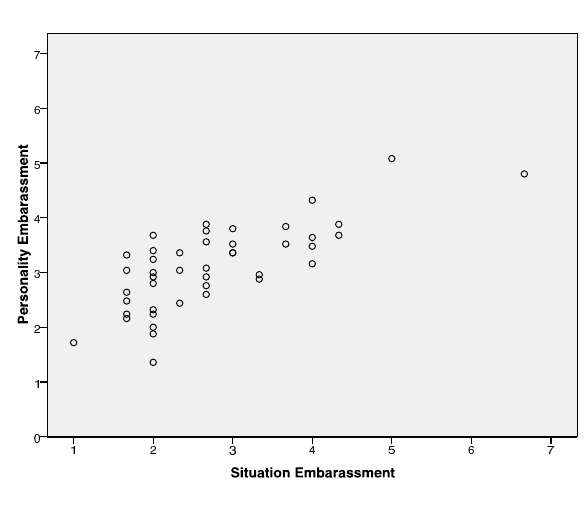
Figure 6. Scatter plot of Situation Embarrassment against Personality Embar- rassment.